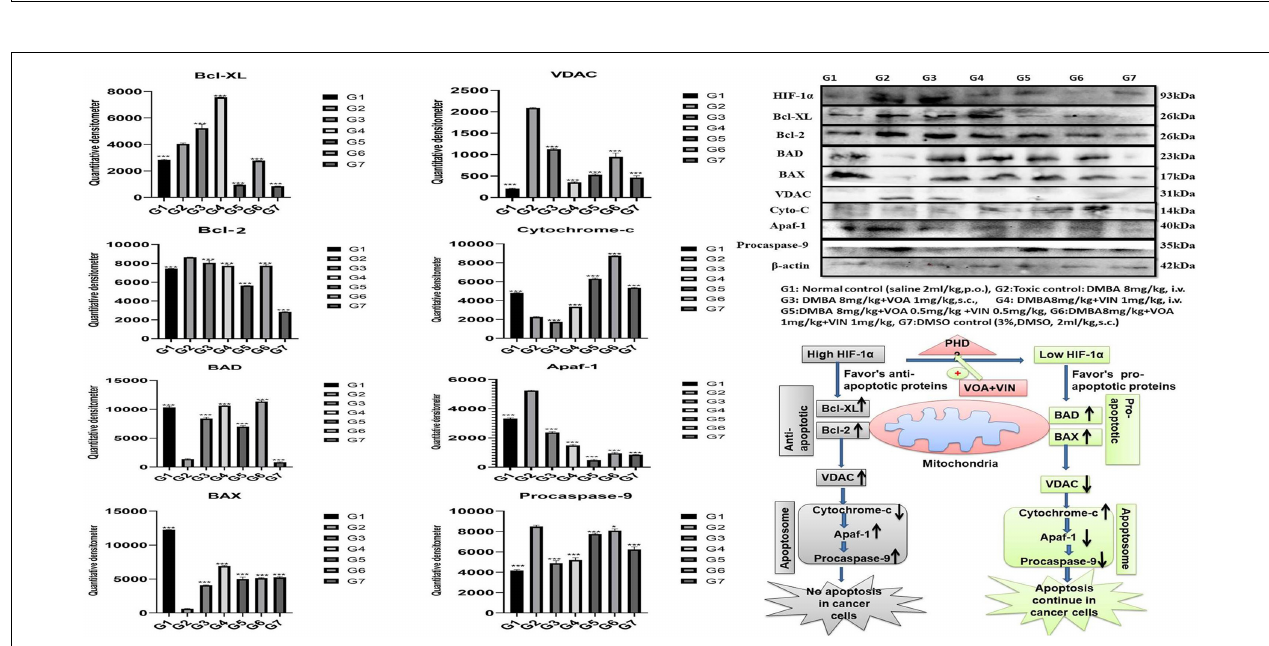
FIGURE 7 | Effect of VOA and VIN on mitochondrial apoptotic markers. Immunoblotting of the respective group [NC, normal control (saline 2 ml/kg); G2, toxic control (DMBA 8 mg/kg, i.v.), G3, voacamine (VOA) (1 mg/kg, s.c.); G4, vincristine (VIN) (1 mg/kg, i.v.); G5, VOA (0.5 mg/kg, s.c.) + VIN (0.5 mg/kg, i.v.); G6, VOA (1 mg/kg, s.c.) + VIN (1 mg/kg, i.v.); and DC-DMSO 3% (2 ml/kg)] for Bcl-XL, BAD, BAX, cytochrome c, caspase 9, Apaf-1, and VDAC concluded the mitochondrial-mediated death apoptosis after DMBA administration. Values are presented as the mean ± standard deviation. Comparisons were made